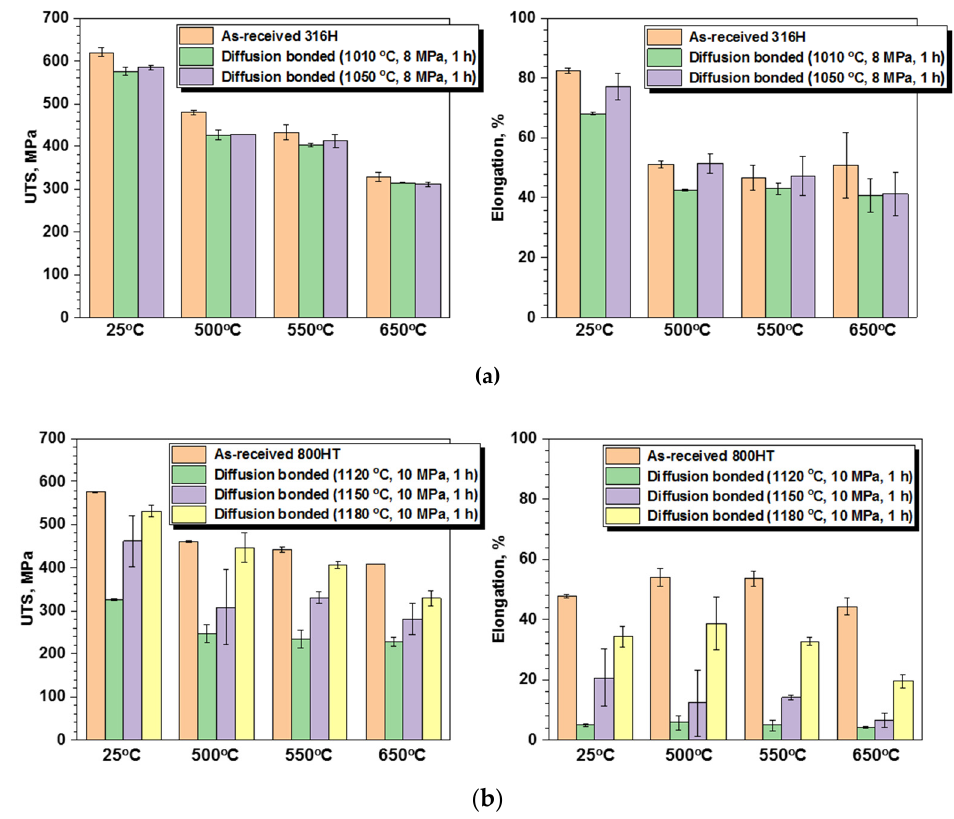
Figure 1. Tensile test results of diffusion bonded ( a ) SS 316H and ( b ) Alloy 800HT compared to as-received materials.